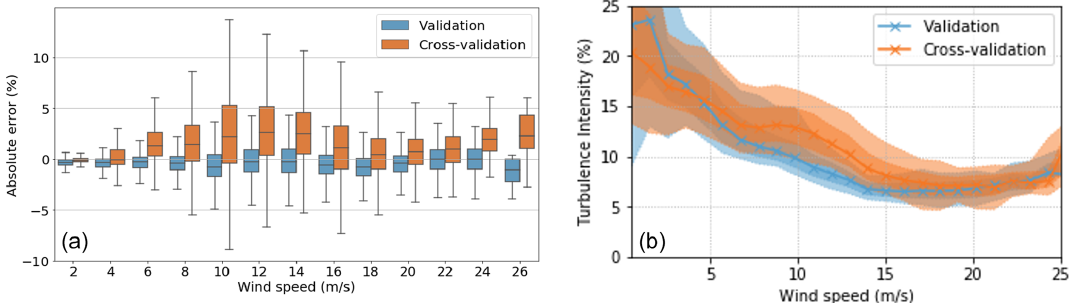
Figure 13. (a) Box plot of error expressed as a percentage of the absolute maximal training DEL value (binned) for the validation and cross-validation turbines plotted against wind speed. (b) Turbulence intensity (%) vs. wind speed (ms − 1 ) for validation and cross-validation turbines.